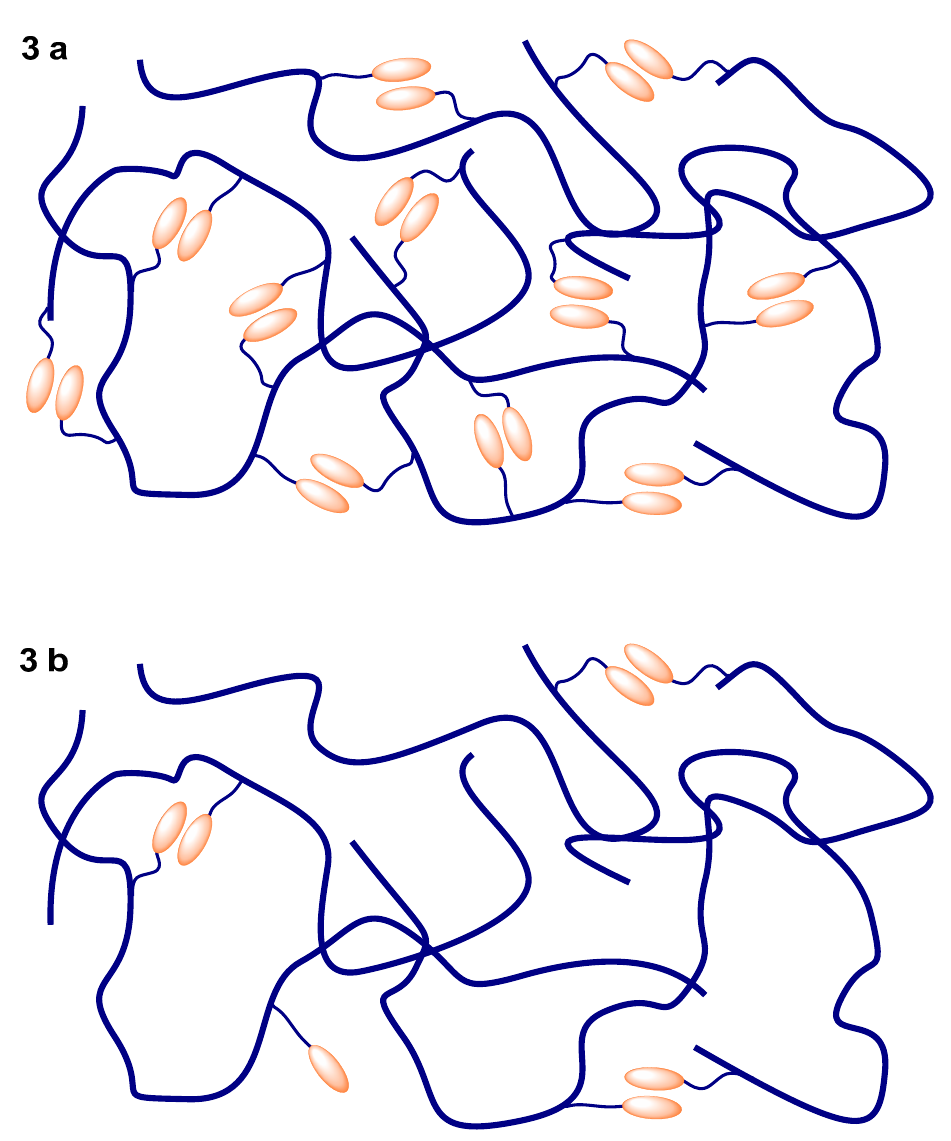
Figure 11. Schematic representation of polymers 3 a,b .